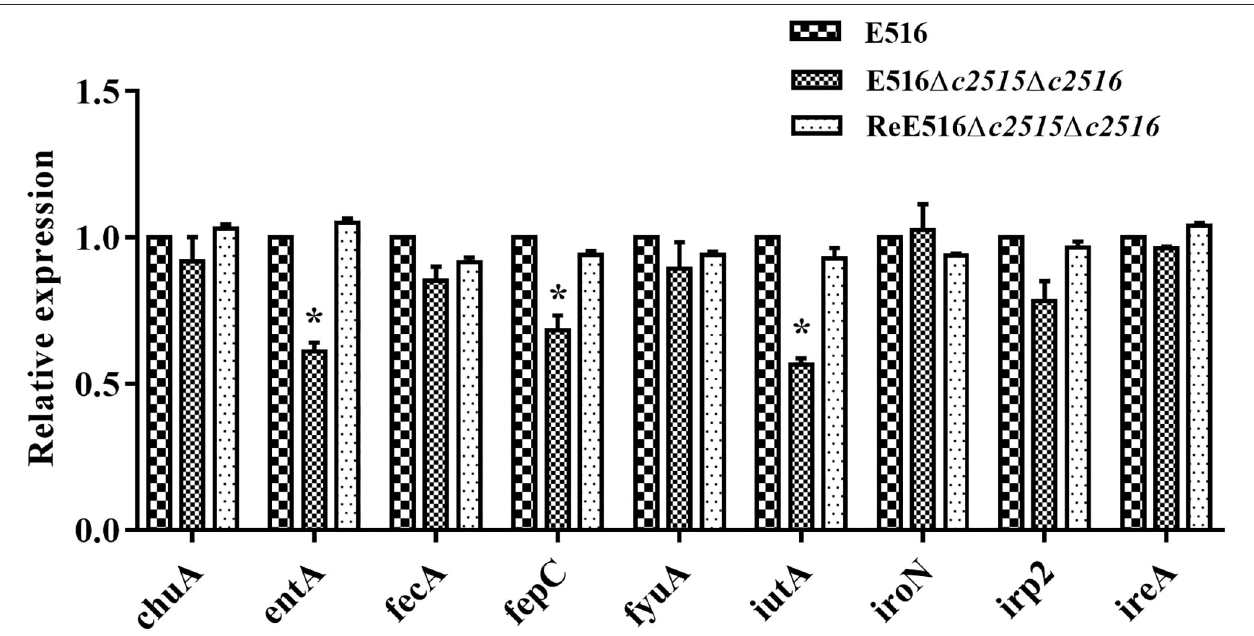
FIGURE 4 | Quantitative real-time reverse transcription-PCR (qRT-PCR) analysis of gene expression. The expression levels of the iron uptake-related genes ( entA , fepC , irp-2 , ireA , fecA , fyuA , iutA , chuA , iroN ) in the WT strain, 1 c2515 1 c2516 , and Re 1 c2515 1 c2516 were tested by qRT-PCR. The relative gene expression levels were calculated using the 2 − 11 Ct method (* P <